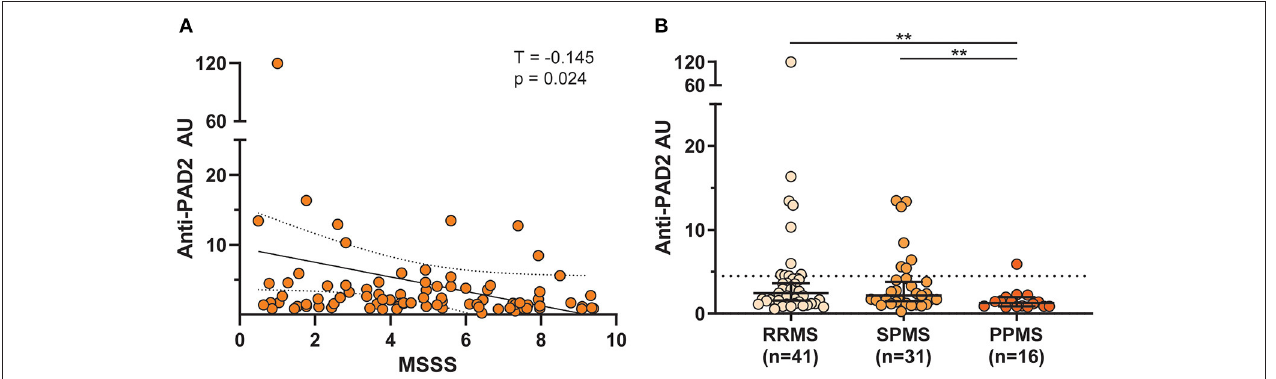
FIGURE 3 | Anti-PAD2 antibody levels by MS subtype and disease severity. (A) Scatterplot showing the multiple sclerosis severity score (MSSS) plotted against anti-PAD2 arbitrary units (AU) of all comers with MS with available clinical data ( n = 88). A univariate analysis was performed between MSSS and anti-PAD2AU and the Kendall’s Tau correlation coefficient (T), p -value, trendline (solid black line), and 95% confidence intervals (dotted black lines) are shown. (B) Anti-PAD2 Arbitrary Units (AU) in people with RRMS ( n = 41), SPMS ( n = 31), and PPMS ( n = 16) were plotted and compared using a Kruskal–Wallis test adjusted for multiple comparisons. The median and 95% confidence interval are shown. ** p < 0.01.